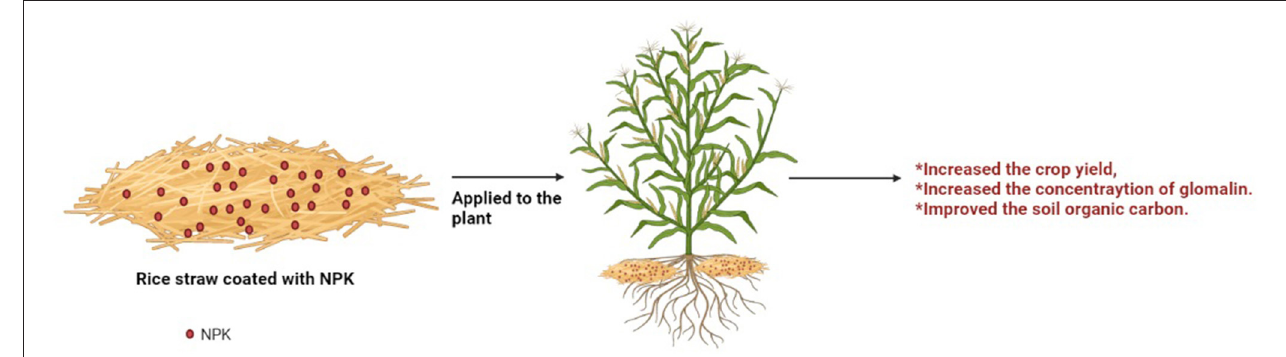
FIGURE 5 | Schematic representation of utilization of rice straw-coated